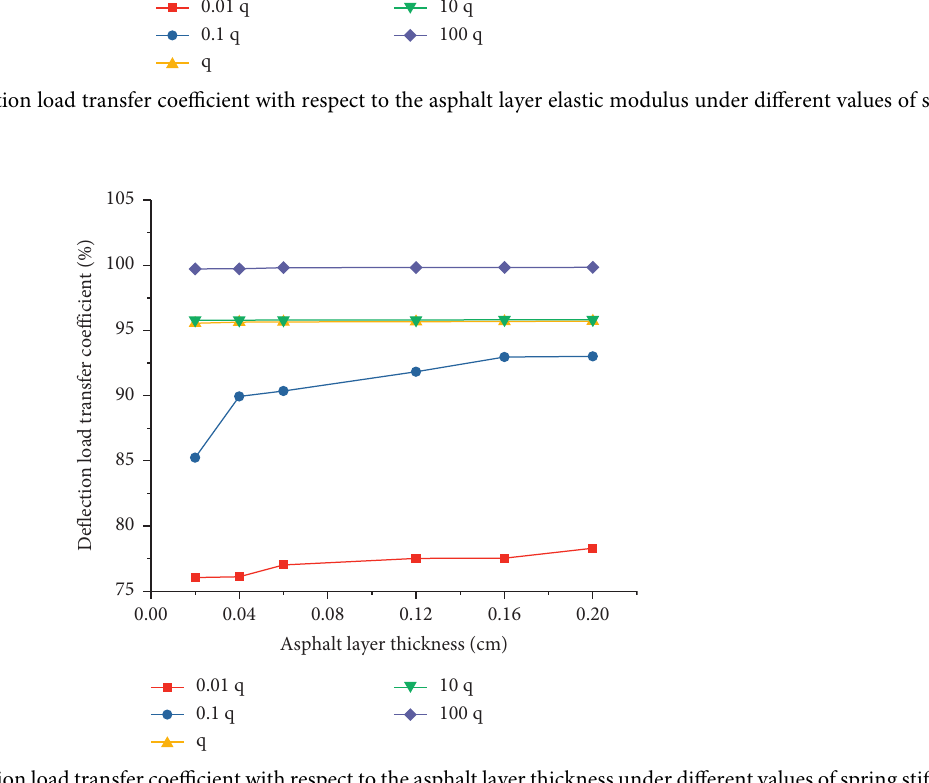
Figure 8: Variation of deflection load transfer coefficient with respect to the asphalt layer thickness under different values of spring